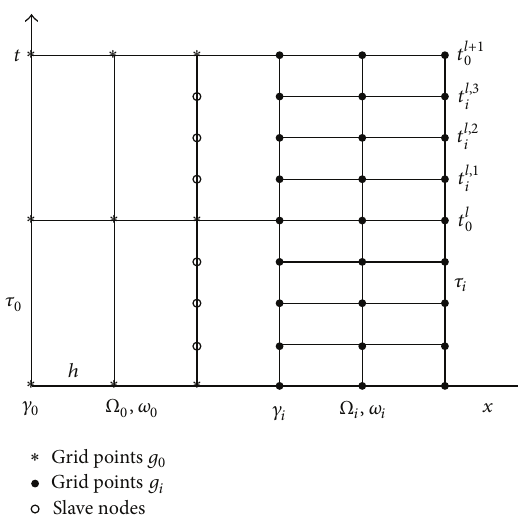
Figure 1: Grid with local refinement in